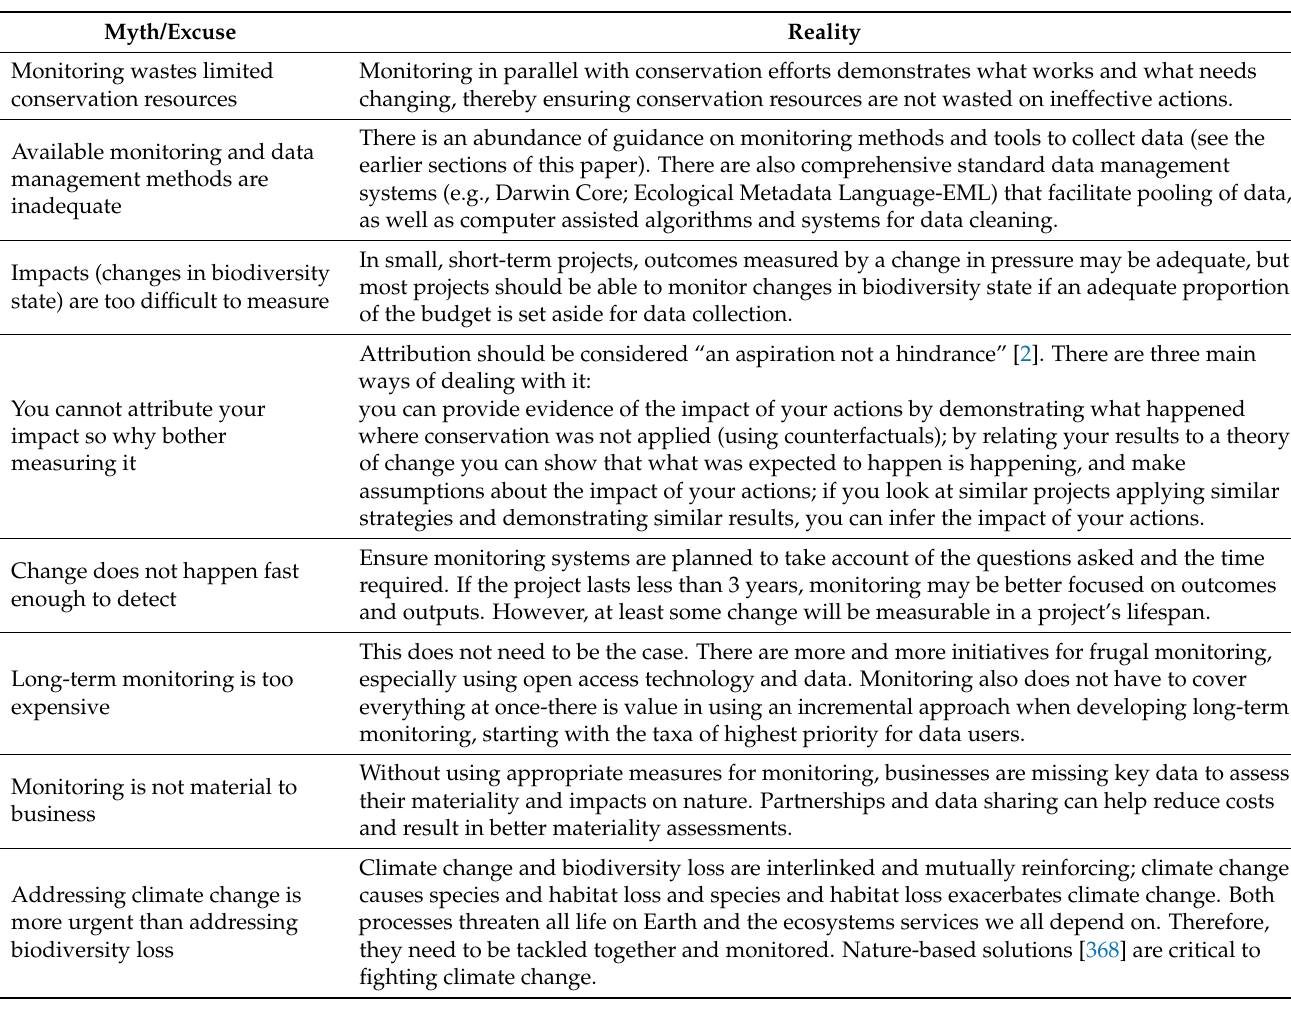
Table 2. Debunking some common monitoring myths and excuses encountered by the